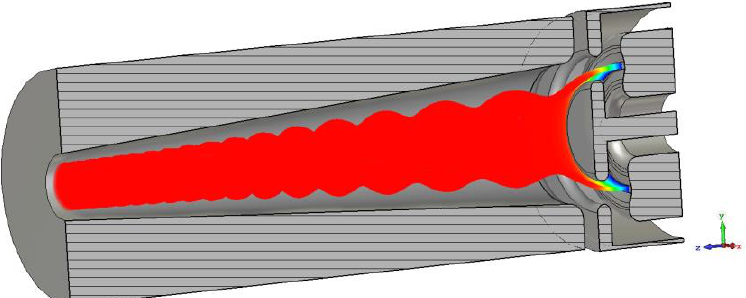
Fig. 1. Scheme of a non-adiabatic electron-optical system.